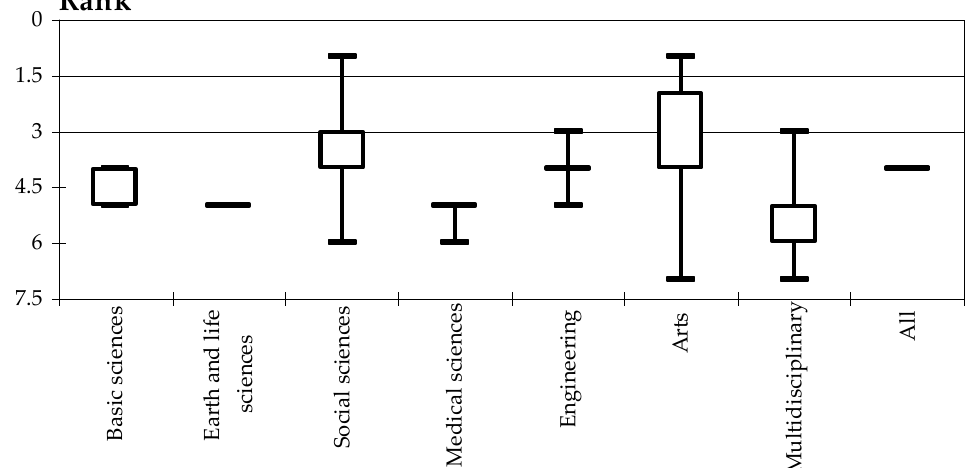
Figure 9. The number of documents published in different aggregated research areas in Slovenia during 2010–2018, measured based on the adjusted number of citations per document. The figure displays boxplots of the ranks of fields computed for each year separately. Results indicate that the ranks cluster in the first third of the ranking, with a large variability.